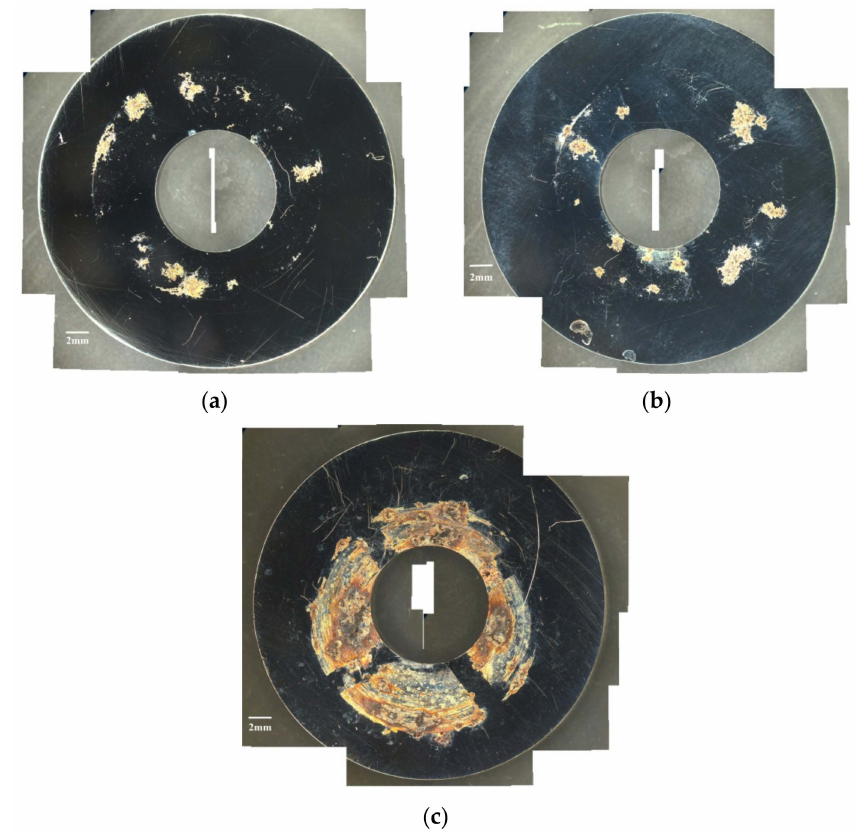
Figure 4. Surface morphologies of the corroded region after 5000 h tests with 1 g / m 2 chloride